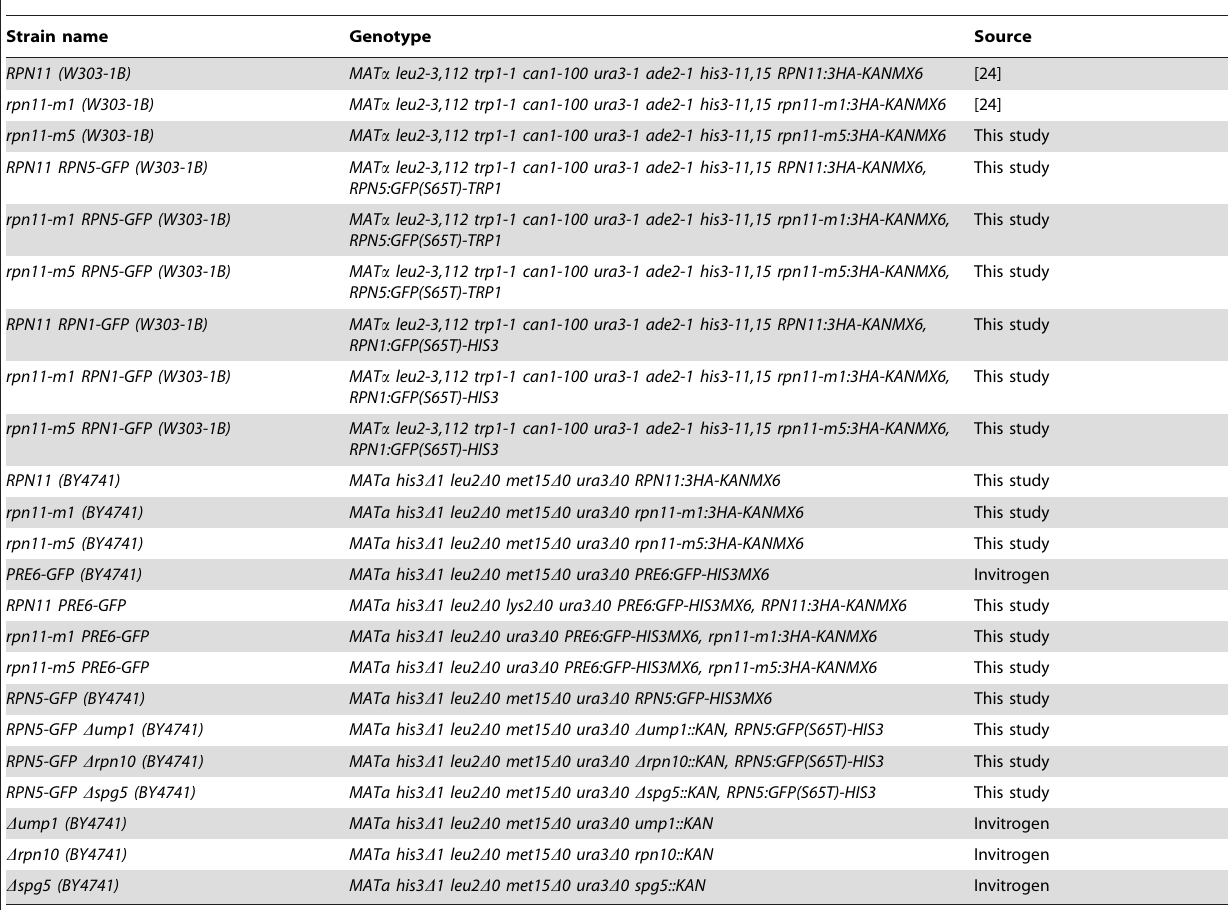
Table 1. Strains used in this